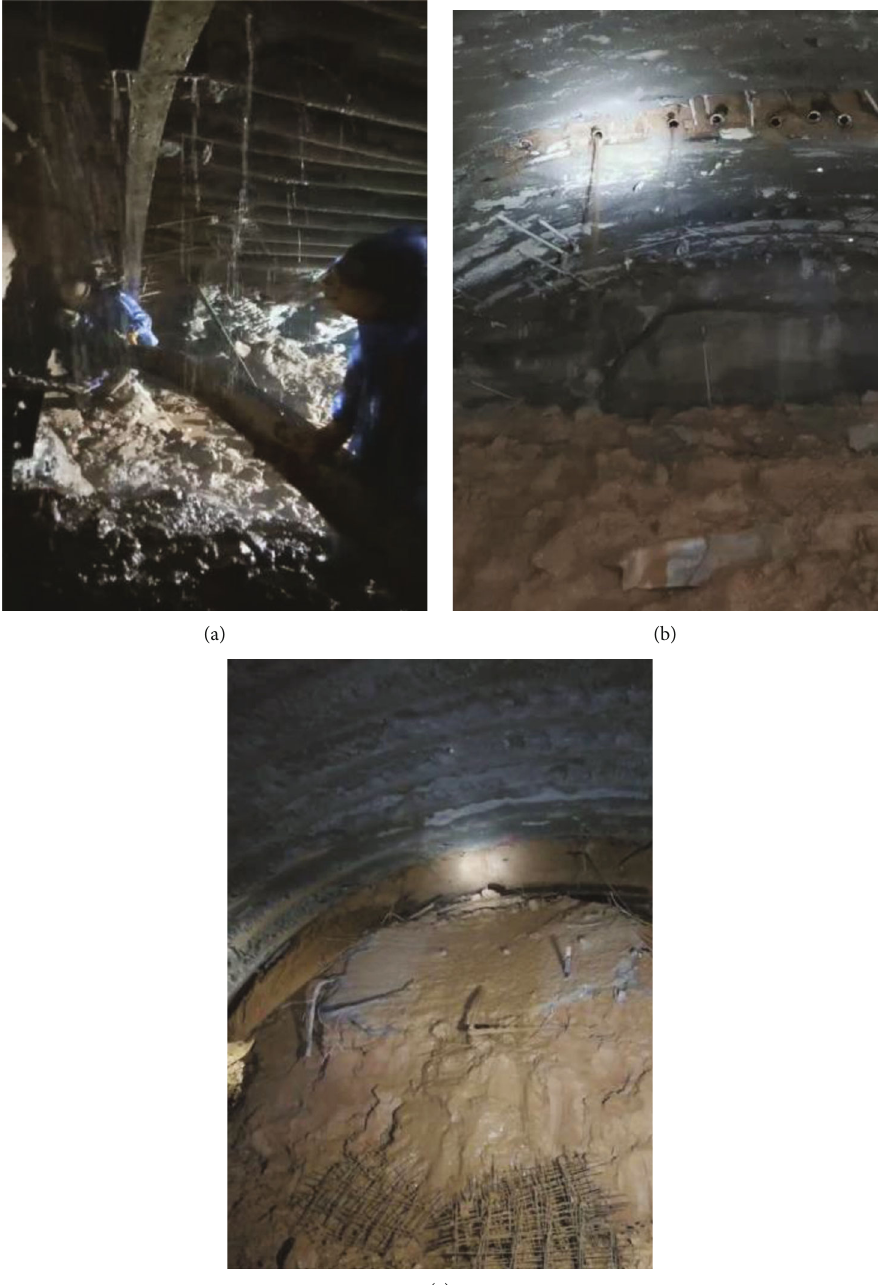
Figure 2: Water gushing and mud inrush at tunnel face: (a) tunnel water gushing; (b) water inrush from advance pipe shed; (c) mud burst on tunnel